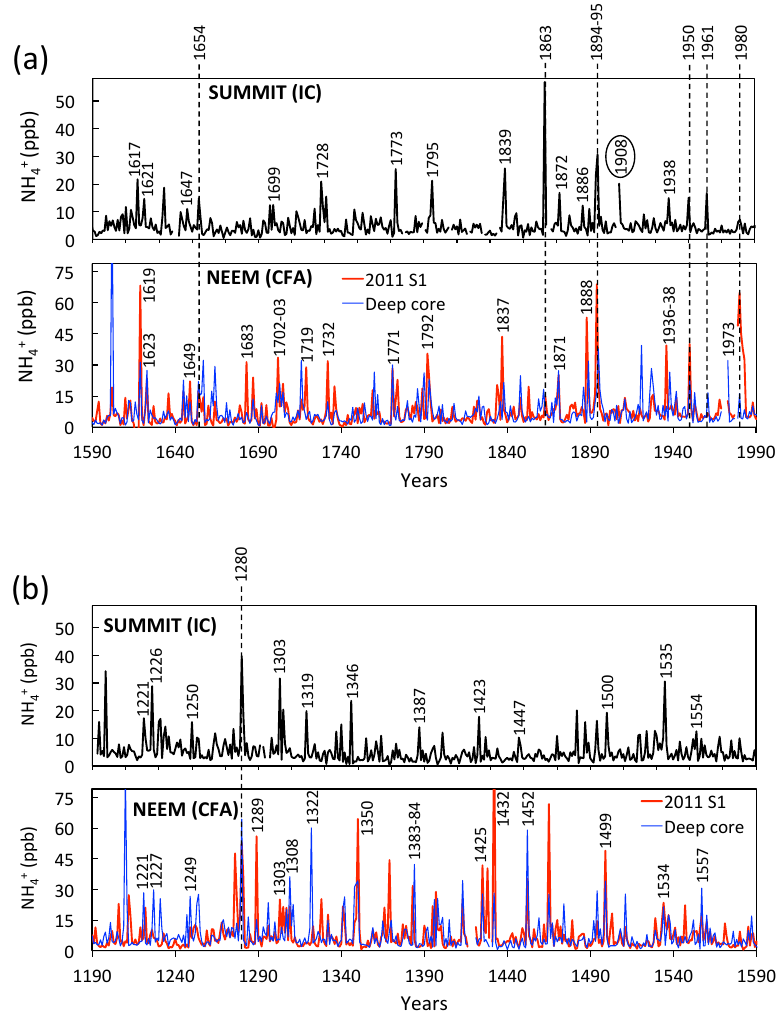
Figure 13. Comparison of ammonium records obtained at Summit and NEEM (NEEM-2011-S1 and the deep core) from 1590 to 1990 (a) and from 1190 to 1590 (b) . All records are seasonally resolved, but data are presented here as annual means. Dashed lines denote the years for which a peak is identified in both cores. The Summit data are from Legrand and De Angelis (1996) and Savarino and Legrand